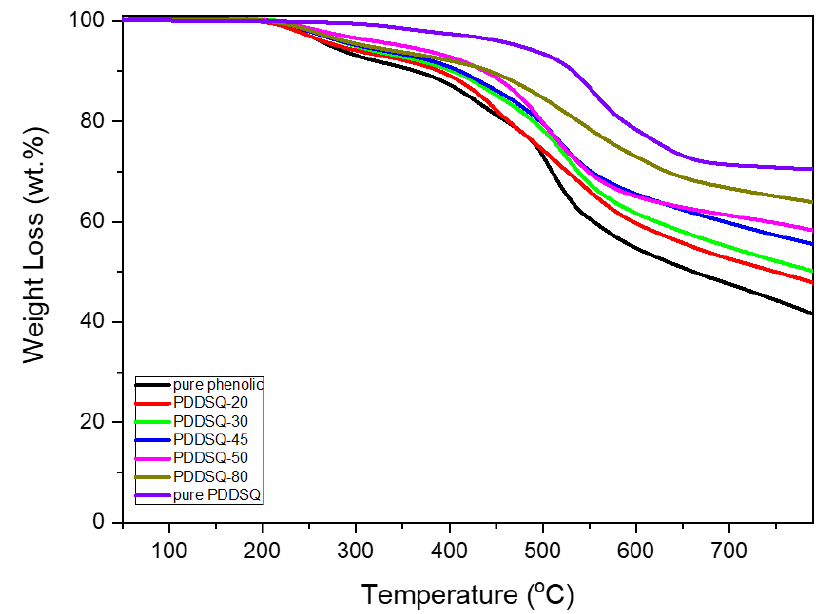
Figure 5. TGA analyses of PDDSQ hybrids containing various DDSQ contents.